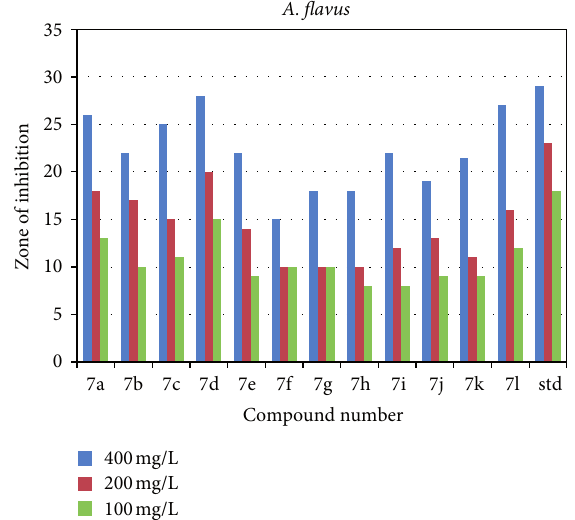
F 4: Antifungal activity against A. �a�us